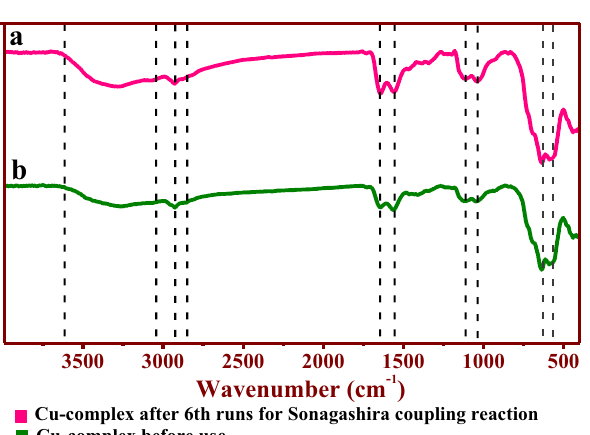
Figure 15. FT ‒ IR spectra of ( a ) γ-Fe 2 O 3 @PEG@PAMAM-Cu, before use; ( b ) γ-Fe 2 O 3 @PEG@PAMAM G 0 -Cu catalyst after 6th runs for the model reaction.